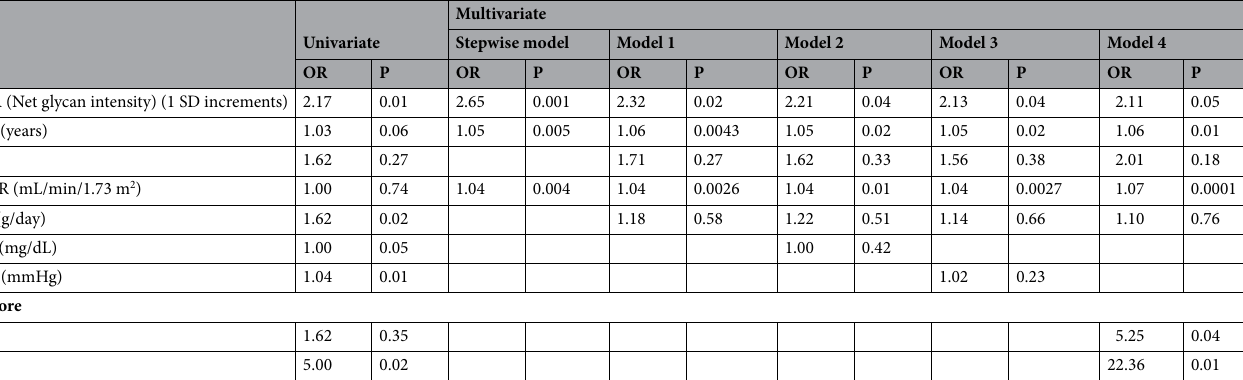
Table 3. Univariate and multivariate logistic regression models using NPA signal and established risk factors to predict renal outcome. Independent variables are as follow; Stepwise Model: NPA + Age + Sex + eGFR + UP;